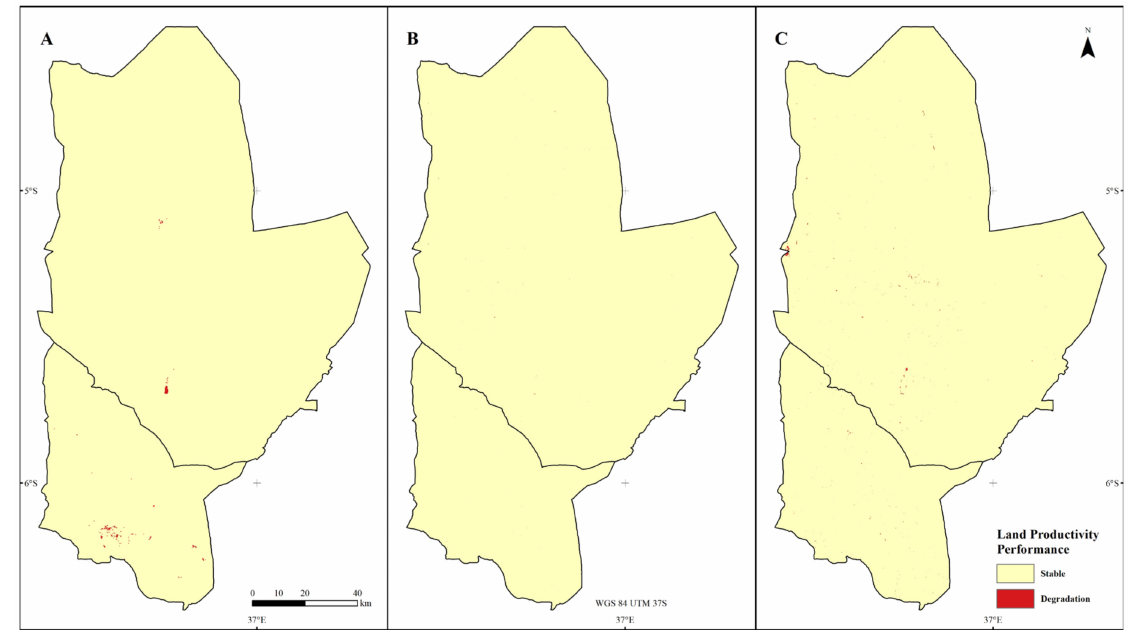
Figure A3. The land productivity component performance generated using ( A ) the default approach with MODIS imagery, ( B ) the adapted approach with Landsat imagery for the baseline period, and ( C ) the adopted approach with Landsat imagery for the monitoring period